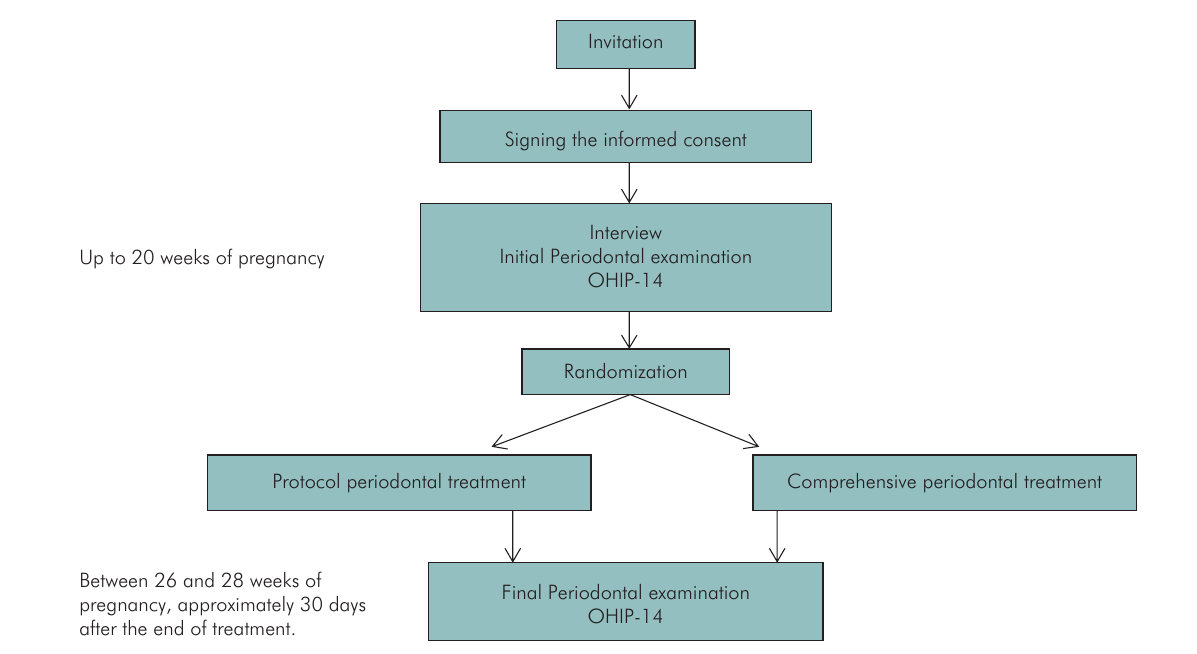
Figure 1. Design of the